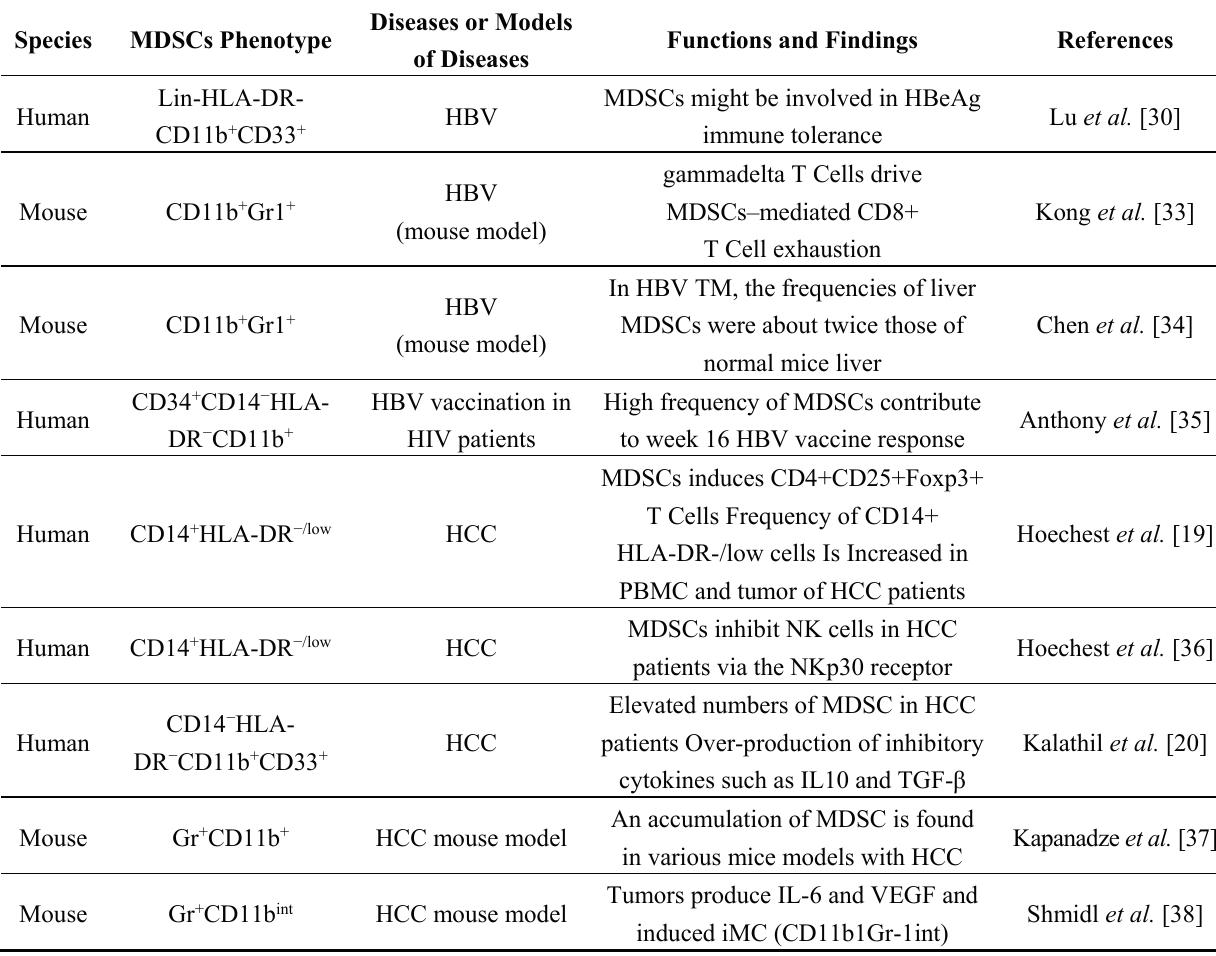
Table 1. Association between MDSCs and HBV or HCC.